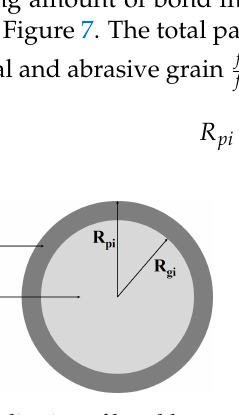
Figure 7. Visualisation of bond layer and abrasive grain; adapted from